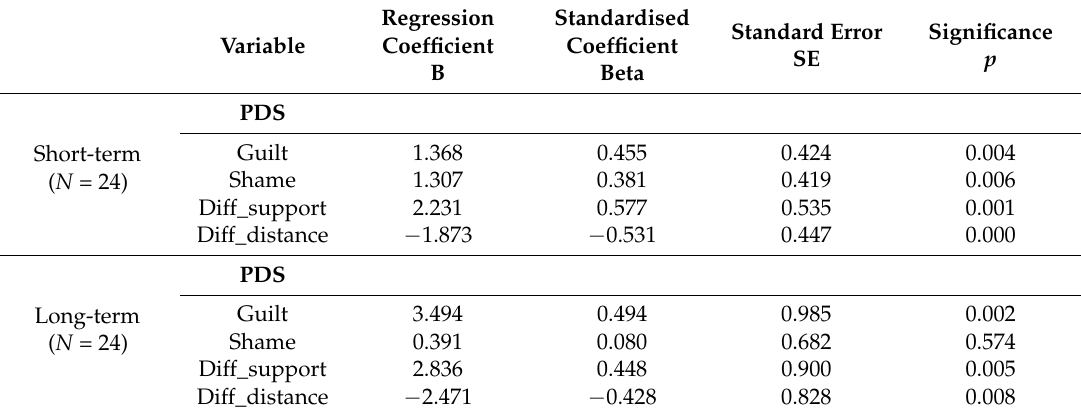
Table 1. Hierarchical multiple regression analyses (differences at t1-t2 and t1-t3 with PDS total score as dependent variables).